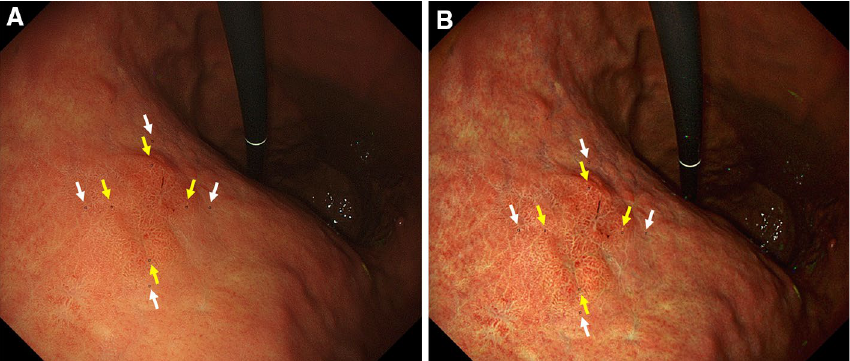
Figure 2. Examples of actual endoscopic images used in the colorimetric evaluation process. A reddish depressed lesion is seen in the posterior wall of the middle gastric body. A total of 8 ROI were annotated on the surrounding non-neoplastic mucosa and EGC. ROIs were set at the same point on the WLI ( A ) and TXI ( B ). The yellow arrows indicate the EGC, and the white arrows indicate the surrounding non-neoplastic mucosa. All ROIs were standardized to 25 pixels (5 ×